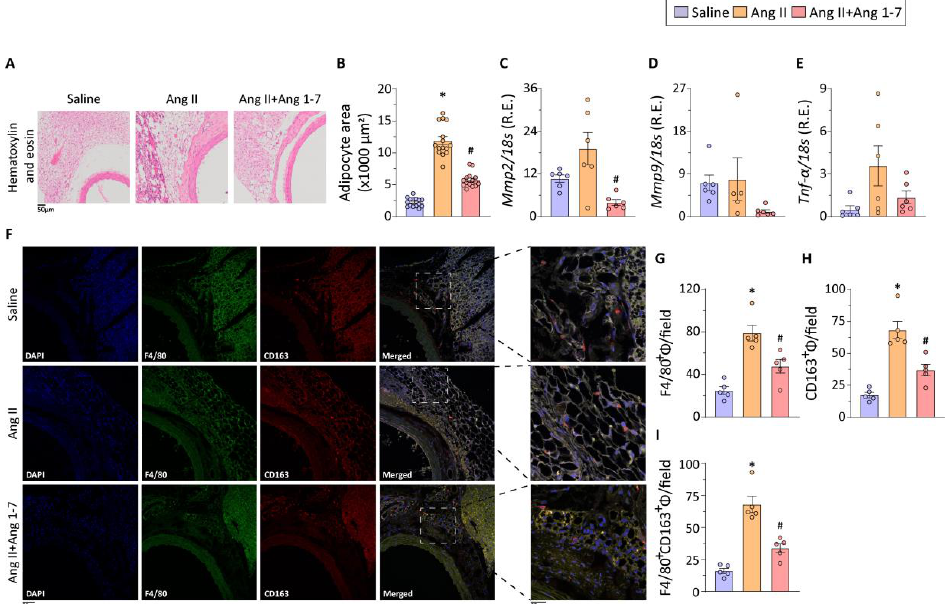
Figure 3. Ang 1-7 reduces perivascular adipose tissue inflammation by attenuating macrophage maturation and polarization. Representative images of hematoxylin and eosin (H&E) staining and brightfield microscopy ( A ) of the thoracic aorta and PVAT, along with quantification of adipocyte cross-sectional area ( B ), demonstrate increased adipocyte hypertrophy and inflammatory cell infiltration in periaortic adipose tissue in response to Ang II infusion; chronic Ang 1-7 administration reduced